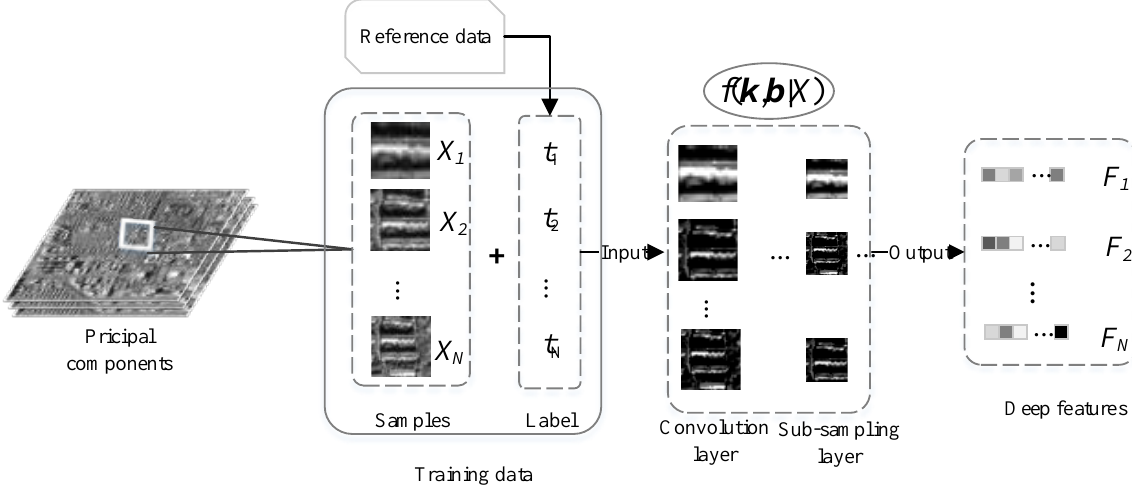
Figure 2. The process of CNN-based spatial feature extraction. The training samples are squared patches. The convolution layer and sub-sampling layer are interspersed in the framework of